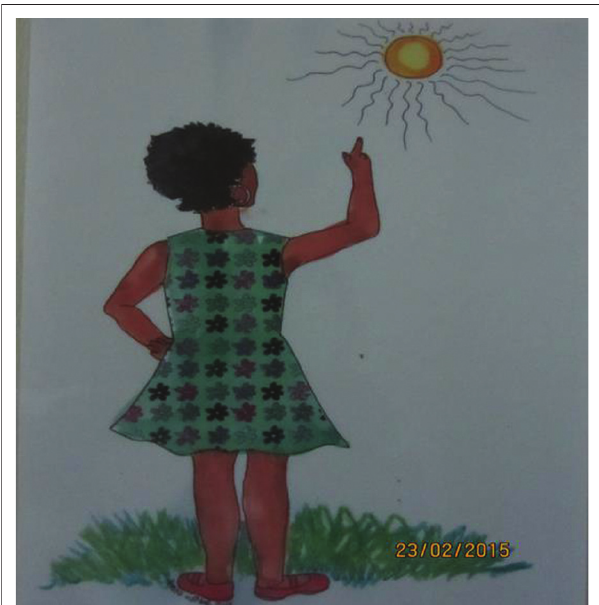
FIGURE 6: Girl pointing at the